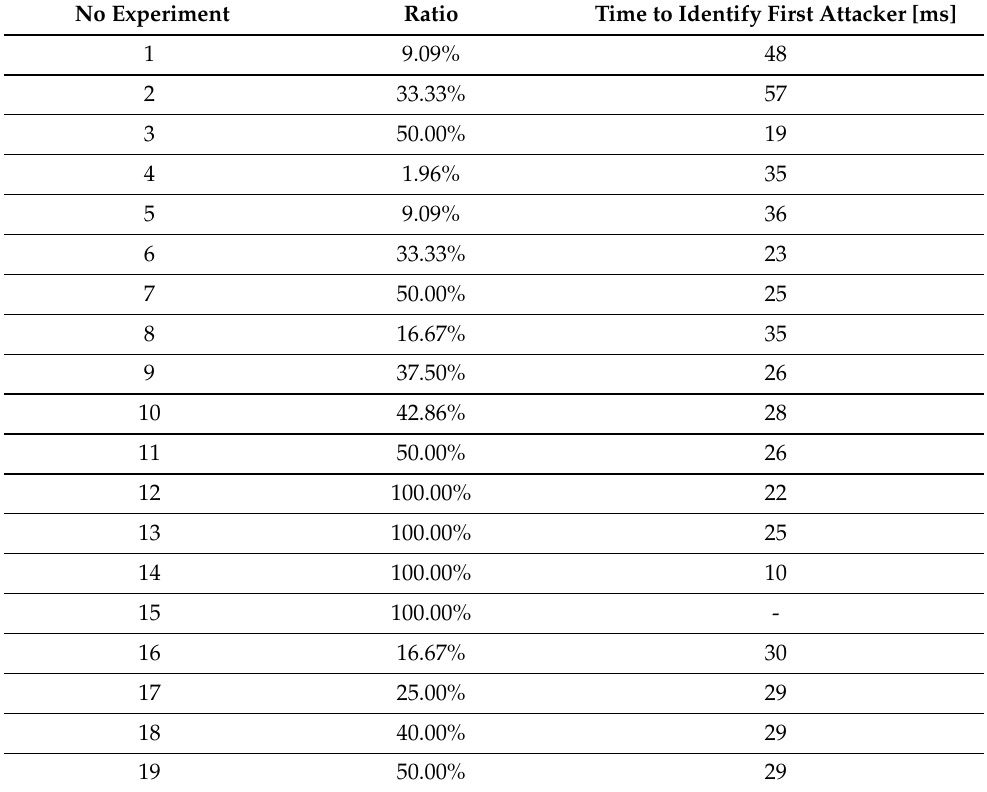
Table 4. Bogus & Sybil Trust Level & Timestamp algorithm—time to identify the first attacker in ms.